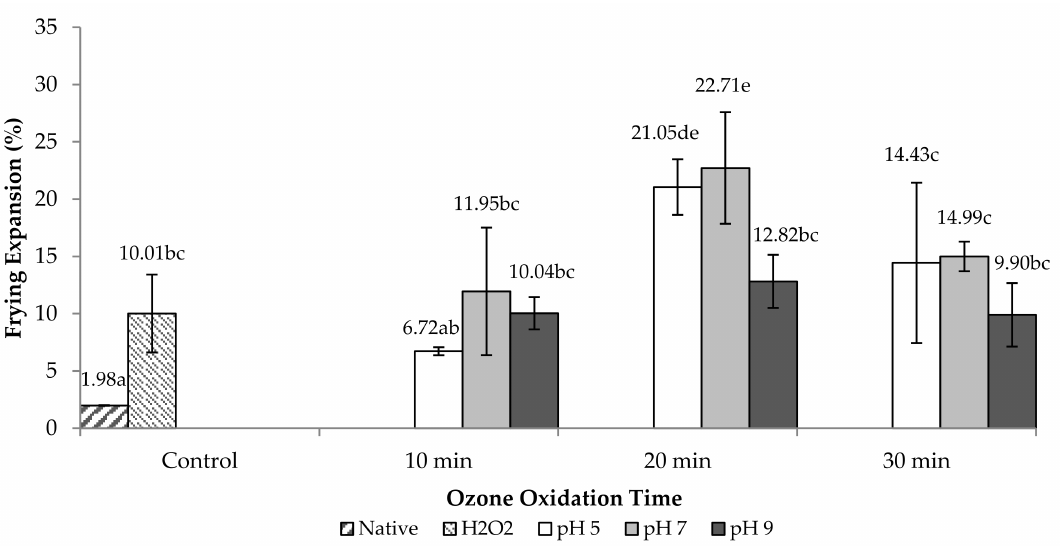
Figure 3. Frying expansion of ozone-oxidized tapioca-coated peanuts compared with native and H 2 O 2 -oxidized tapioca. Bars represent the standard deviation ( n = 3). Different uppercase letters on the bars indicate the significant difference ( P <